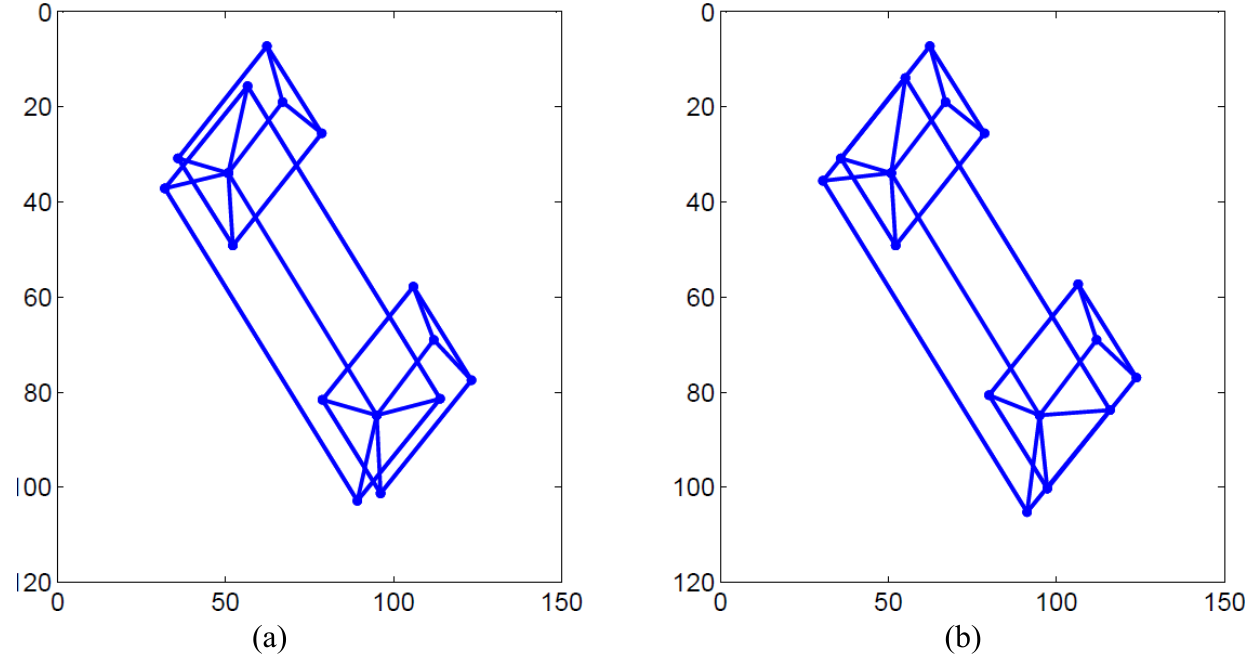
Figure 8. ( a ) Before node refinement; ( b ) After node refinement. Merged parametric model before (a) and after (b) node refinement.